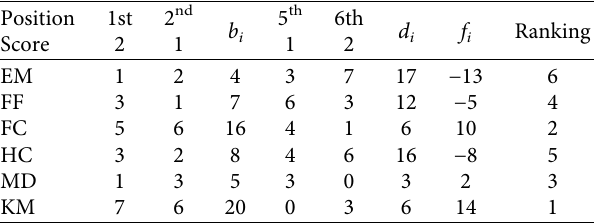
Table 10: Priority of each alternative. Table 11: Statistical analysis of rankings for all 20 UCI data